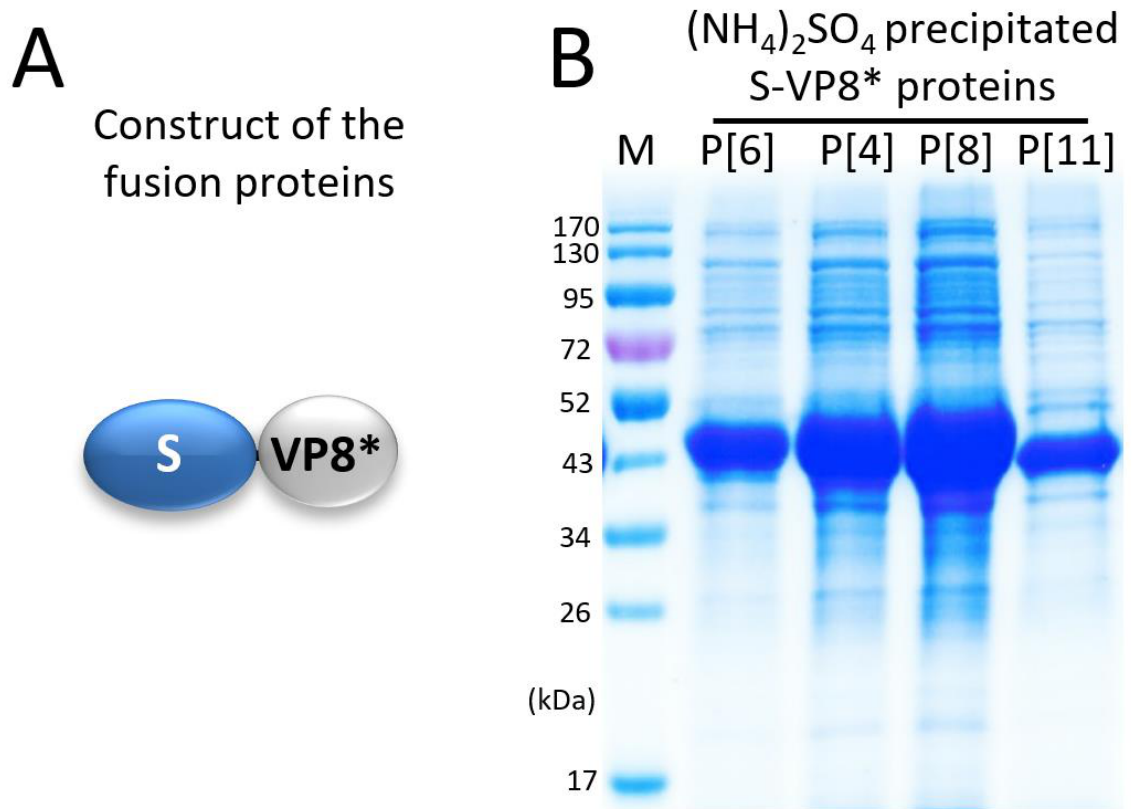
Figure 1. Expression and selective precipitation of the S-VP8* fusion proteins. ( A ) Schematic diagram of the S-VP8* fusion proteins. S, modified norovirus shell (S) domain; VP8*, rotavirus VP8* domain. ( B ) SDS-PAGE of the ammonium sulfate [(NH 4 ) 2 SO 4 ] precipitated S-VP8* fusion proteins at about 43 kDa, which contain the VP8* domains of P[6], P[4], P[8], and P[11], respectively. Lane M is a pre-stained protein standards with indicated molecular weights in